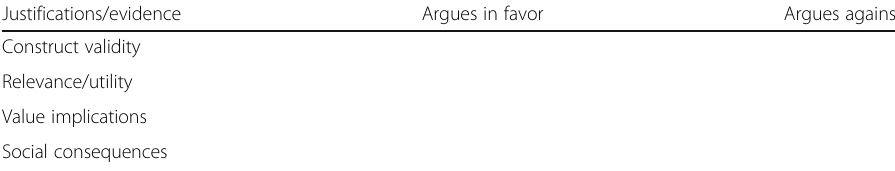
Table 1 Analysis of justifications for the use of tests Justifications/evidence Argues in favor Argues